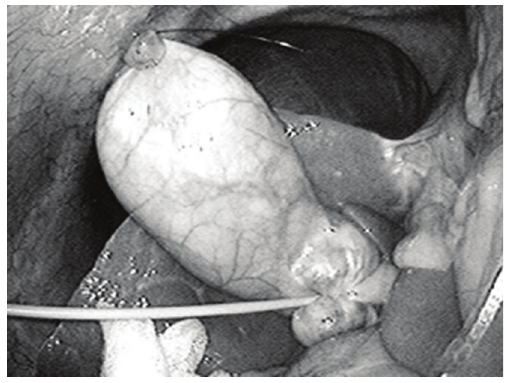
Figure 4: The nylon suture elevates the gallbladder and a fine loop- type retractor pulling the infundibulum presents Calot’s